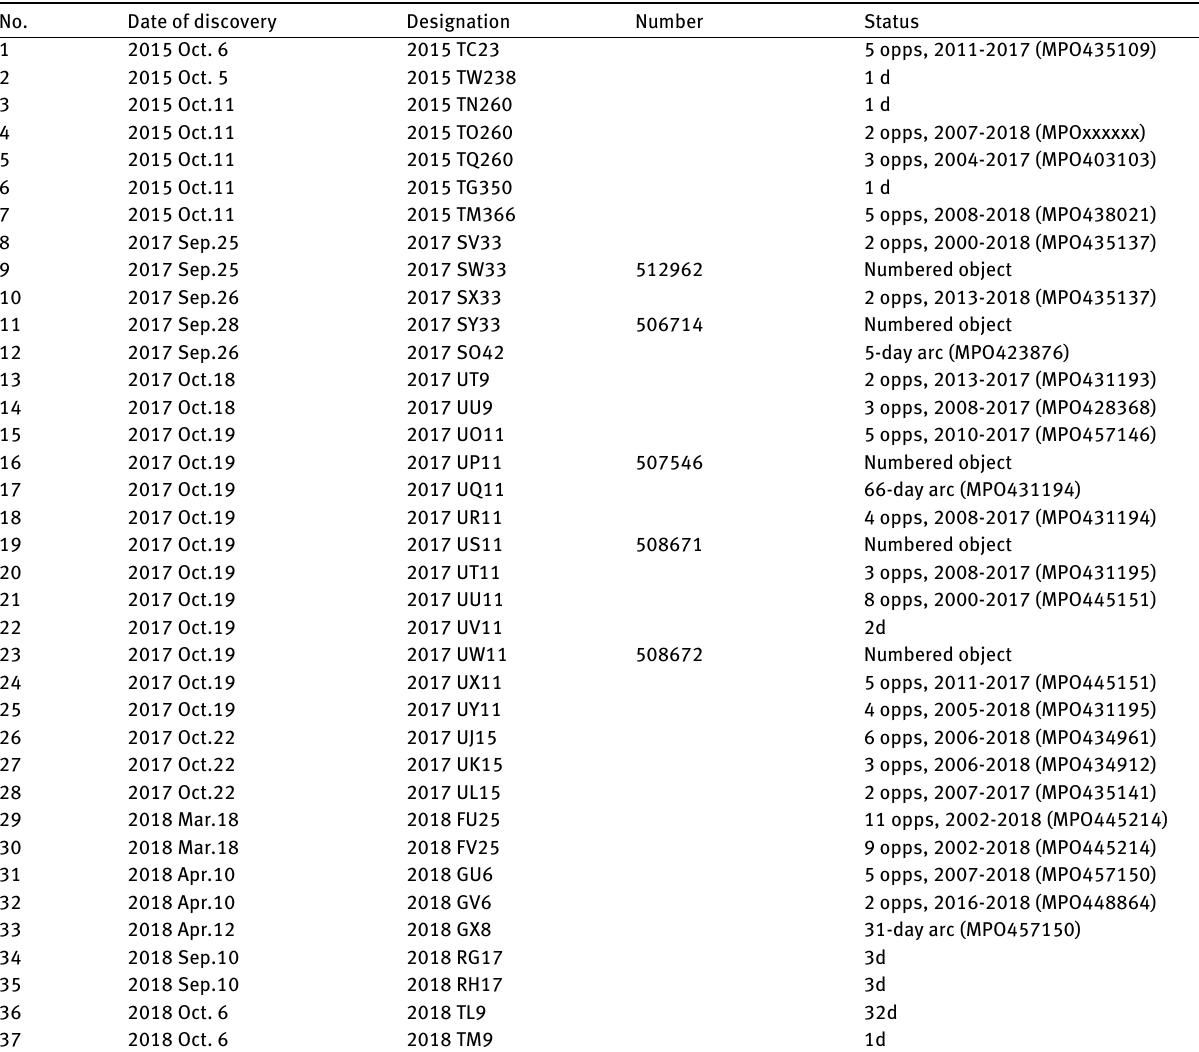
Table 1. List of asteroids discovered at the Baldone Observatory in 2015–2018. No.